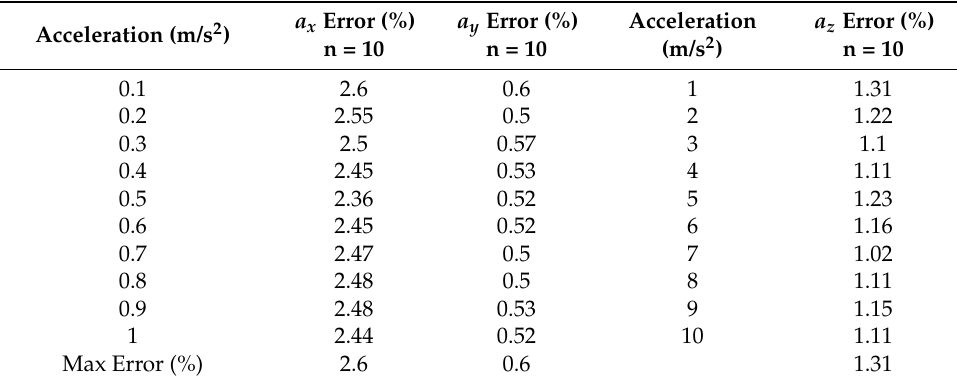
Table 6. Measurement precision of the six-axis accelerometer.